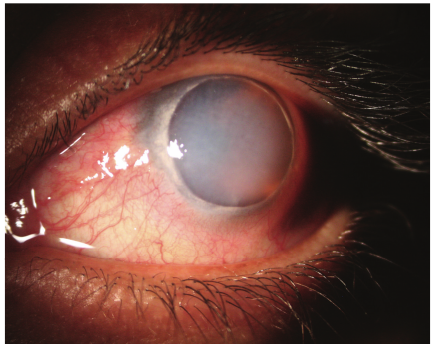
Figure 2: Photograph of the left eye demonstrating similar presen- tation to the right but with diffuse edema.